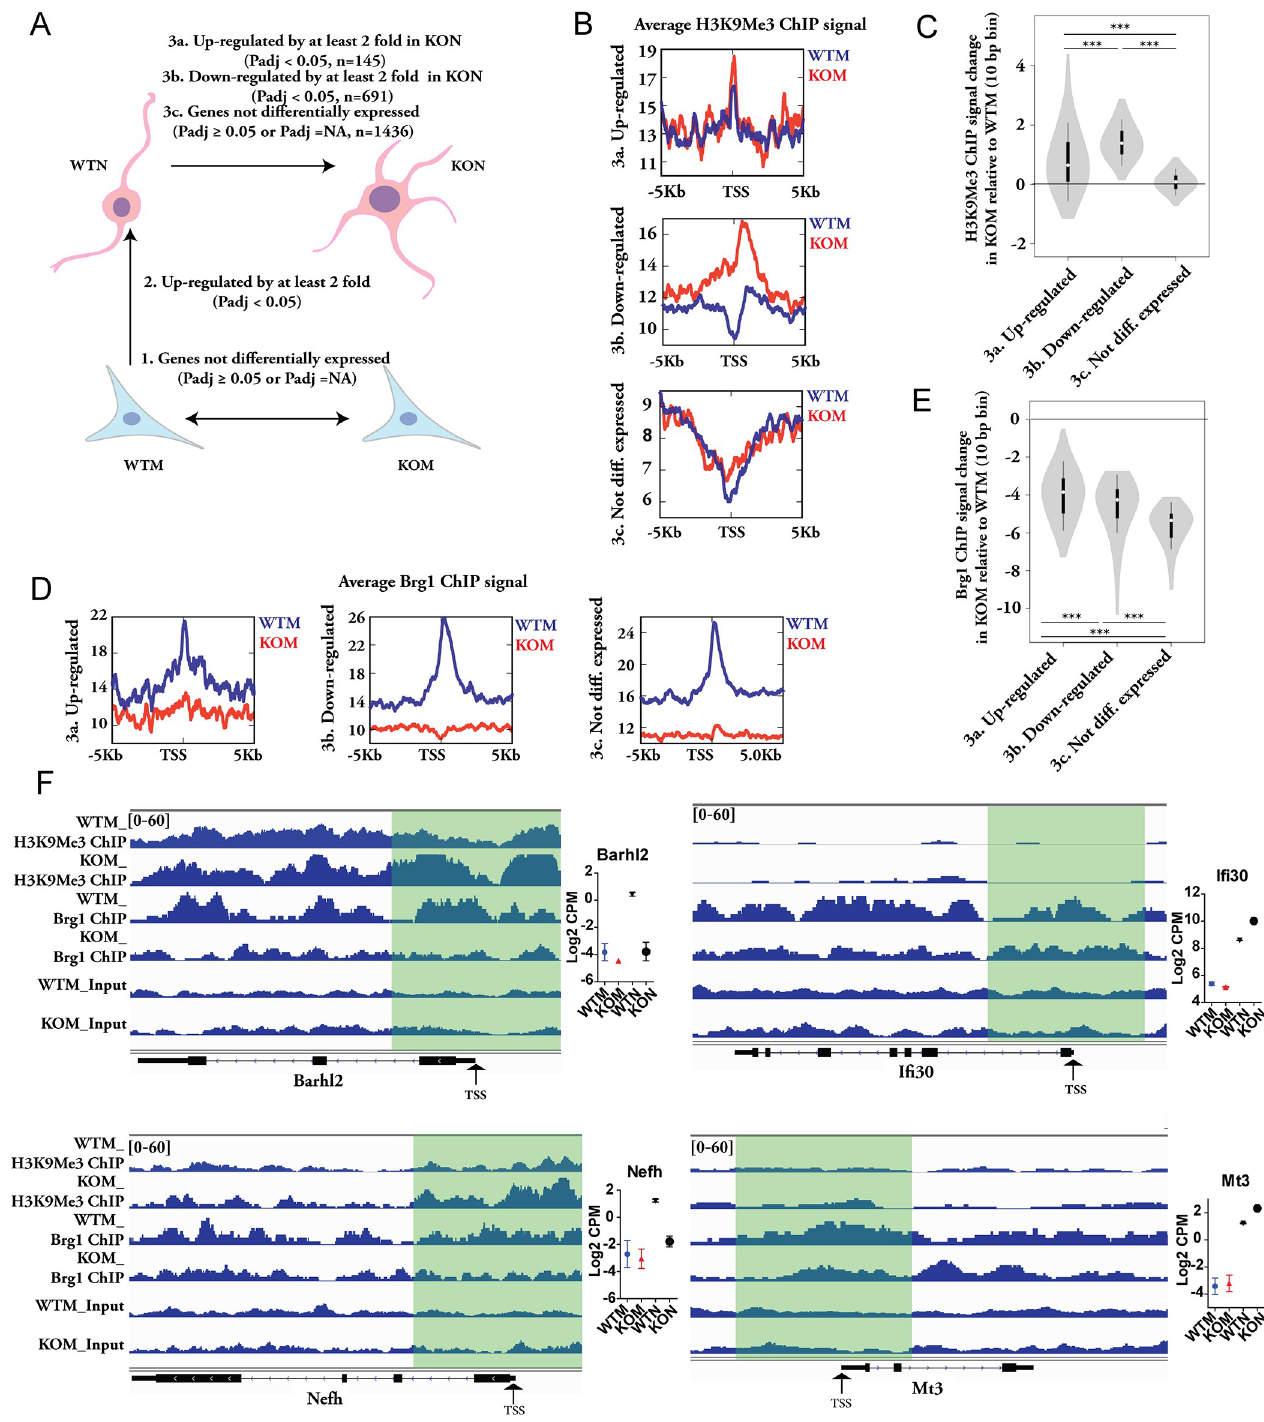
Fig 7. β -actin dependent Brg1 chromatin binding and H3K9Me3 changes in MEFs regulate the expression of neurogenic programs in direct reprograming. (A) Schematics of the selection of genes involved in neurogenesis of direct reprograming. 1. The genes differentially expressed WTM and KOM were removed. 2. After the filter 1, the remaining genes that are up-regulated by at least 2 fold in β -actin +/+ WT background during direct reprograming (up-regulated in WTN in comparison to WTM) were further selected. 3. Followed by the filter 2, the genes were further filtered as follows: genes up-regulated in KON in comparison to WTN (3a), genes down-regulated in KON (3b) or genes that are not differentially expressed (3c). The final lists of filtered gene in 3a, 3b and 3c were selected respectively for the downstream analysis of H3K9Me3 and Brg1 binding profiles. (B) Average H3K9Me3 Chip-seq signal within ± 5kb of TSS of genes in gene lists of 3a, 3b, and 3c between WTM and KOM. (C) The difference of H3K9Me3 Chip-seq signal in each10 bp bin within ± 5kb of TSS